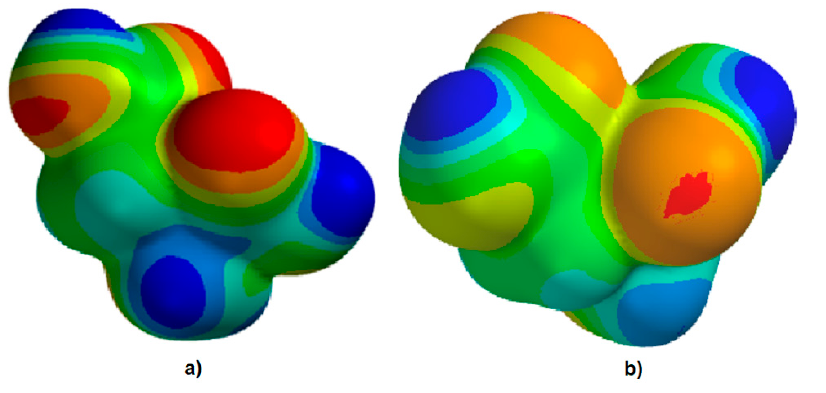
Figure 2. Electrostatic potential map generated with Hartree-Fock ( a ) and Density Functional ( b ) methods.